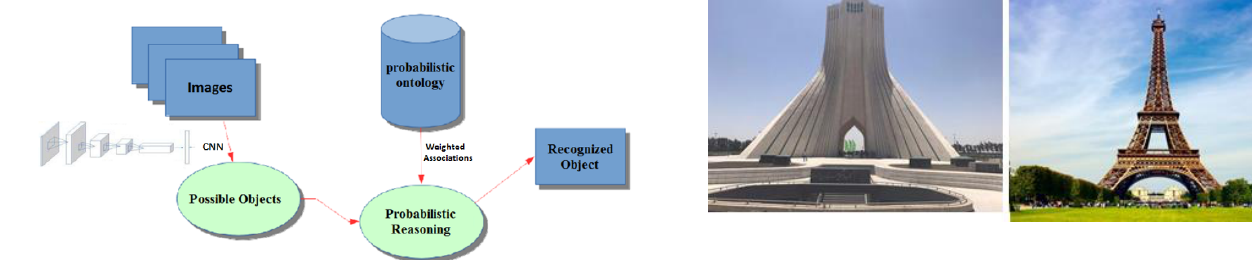
Figure 6 . Reasoning using a probabilistic ontology